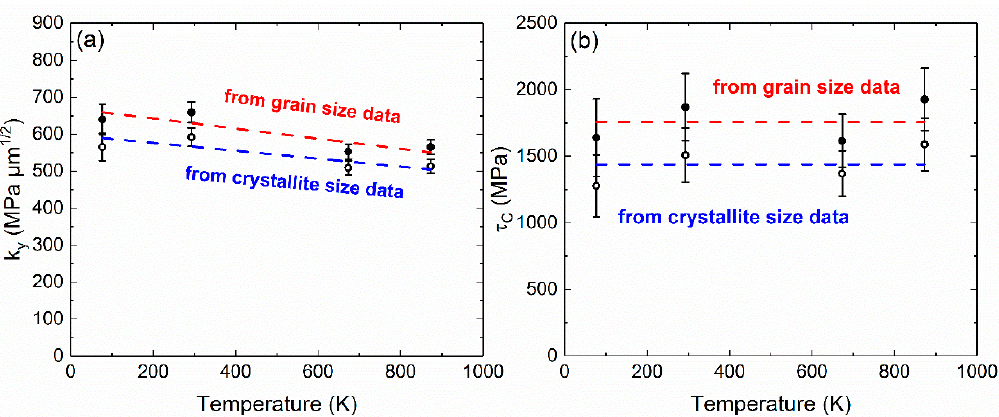
Figure 10. Temperature dependence of ( a ) Hall–Petch slope ( k y ) obtained from grain size data (red) and crystallite size data (blue) and ( b ) critical boundary strength ( τ c ) obtained from grain sizes (filled points) and crystallite sizes (white points) assuming a pile-up of screw dislocations.